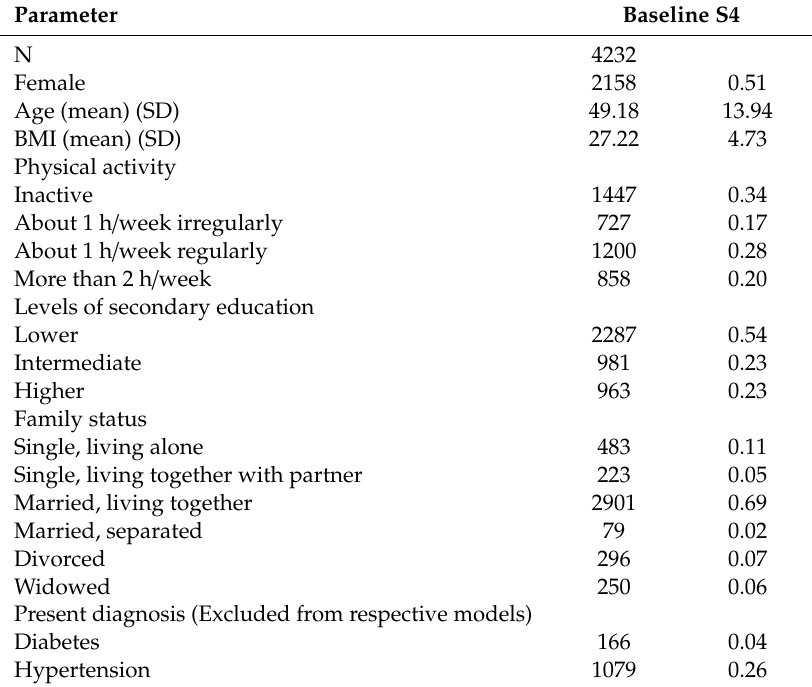
Table 1. Descriptive information on the baseline S4 study for the total